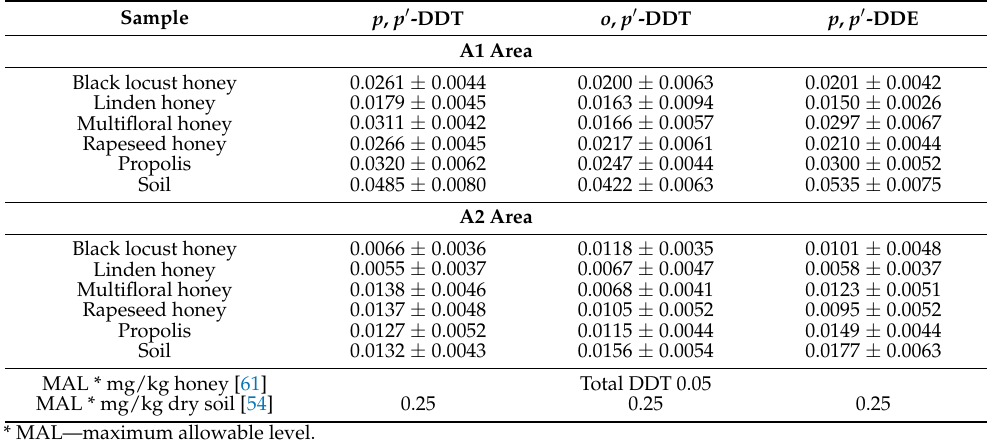
Table 5. Pesticide concentrations (mean ± standard deviation) (mg/kg) in honey, propolis and soil samples collected from studied areas (A1 area with intense industrial activity, A2 area with entirely devoid of industrial activity, but with moderate agricultural activity).